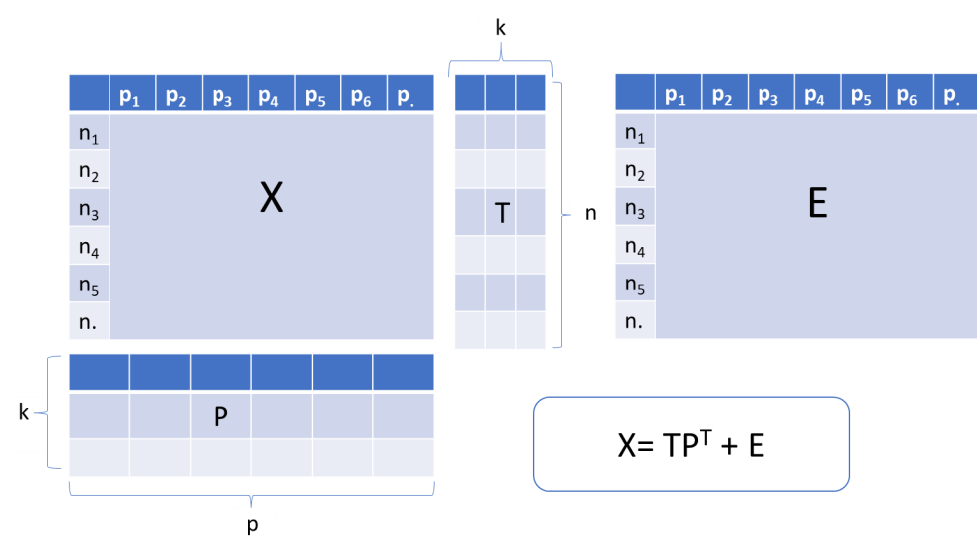
Figure 2. Schematic representation of Principal Component Analysis where X: raw data, T: Scores matrix, P: Loadings matrix, E: Residuals matrix. Adapted from Panchuk et al.[106] and Dupont et al.[107].